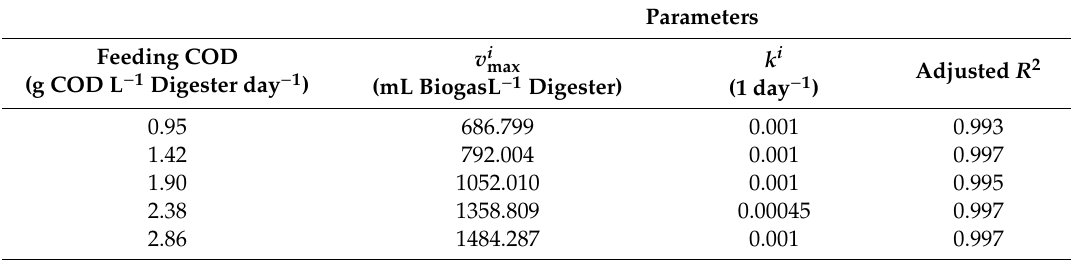
Table 2. Fitting results of first-order kinetics from batch